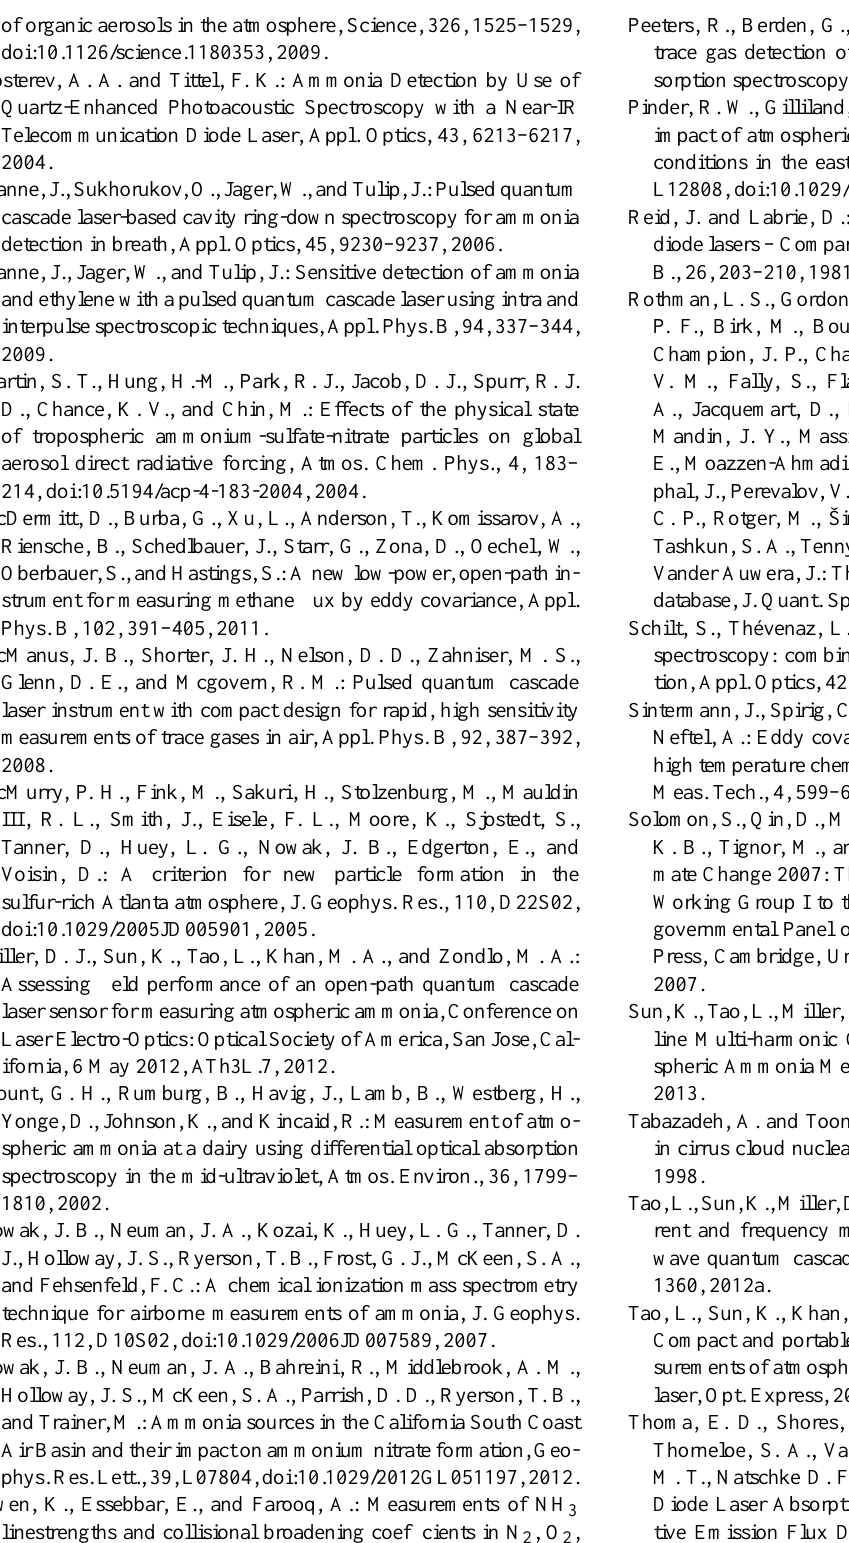
Tabazadeh, A. and Toon, O. B.: The role of ammoniated